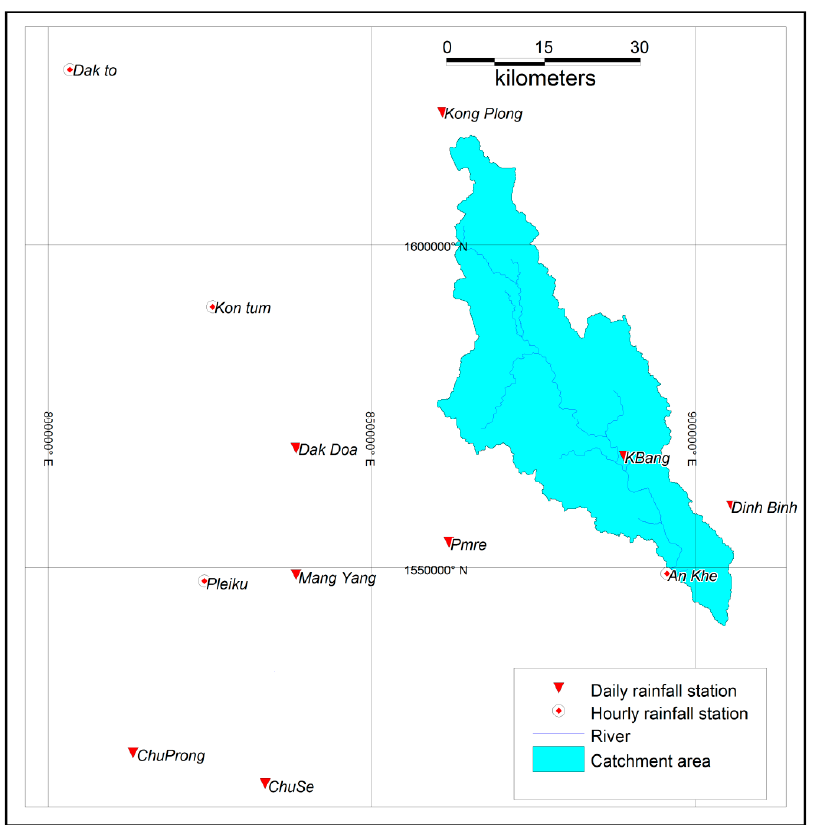
Figure 1. Distribution of meteorological stations across Ba River catchment.